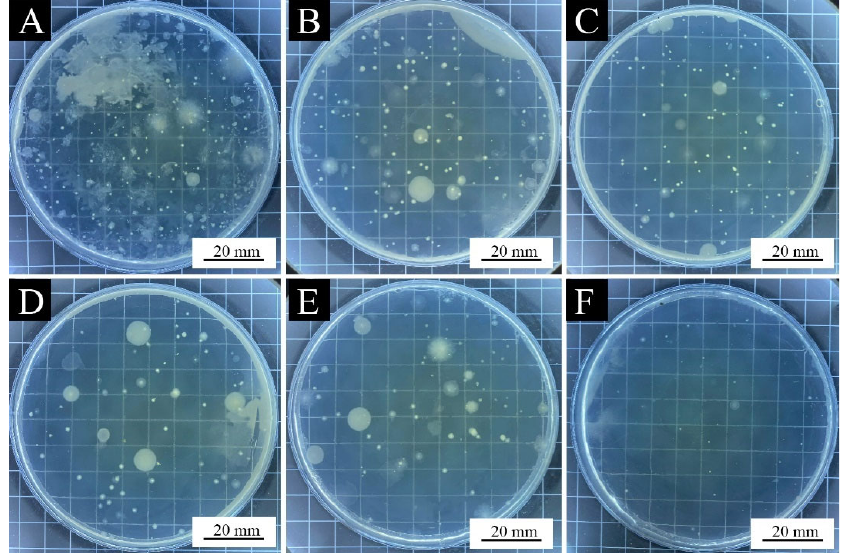
Figure 13. Staphylococcus aureus colonies recovered after antibacterial test of the paint films: ( A ) 0% microcapsule ‐ loaded film, ( B ) 1.0% microcapsule ‐ loaded film, ( C ) 3.0% microcapsule ‐ loaded film, ( D ) 6.0% microcapsule ‐ loaded film, ( E ) 9.0% microcapsule ‐ loaded film, and ( F ) 12.0% microcap ‐ sule ‐ loaded film. 3.6. Analysis of the Influence of Different Microcapsule Loading on the Optical Properties of the Paint Films The chromaticity value and color difference of the paint films are indicated in Table 13 and Figure 14. With the increase in the aloe ‐ emodin microcapsules, the color differ ‐ ence of the films loaded with the microcapsules compared with the film without micro ‐ capsules was on the rise. The b value indicating the yellow color also showed the same trend, which indicated that the yellow degree of the paint films became darker. This oc ‐ curred because the microcapsule itself was yellow. On the contrary, the value of L , which